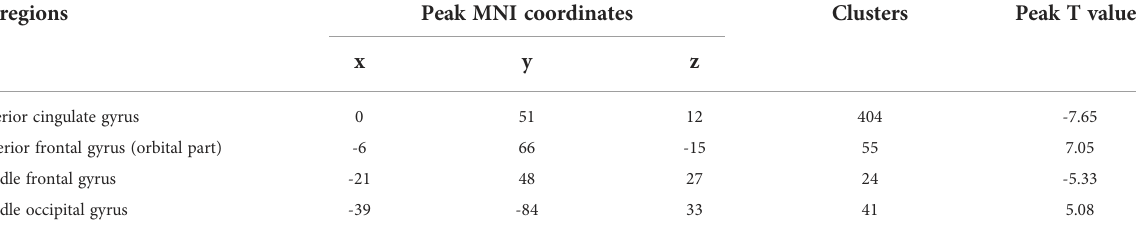
TABLE 2 Brain regions showed altered fALFF in CRC patients. Brain regions